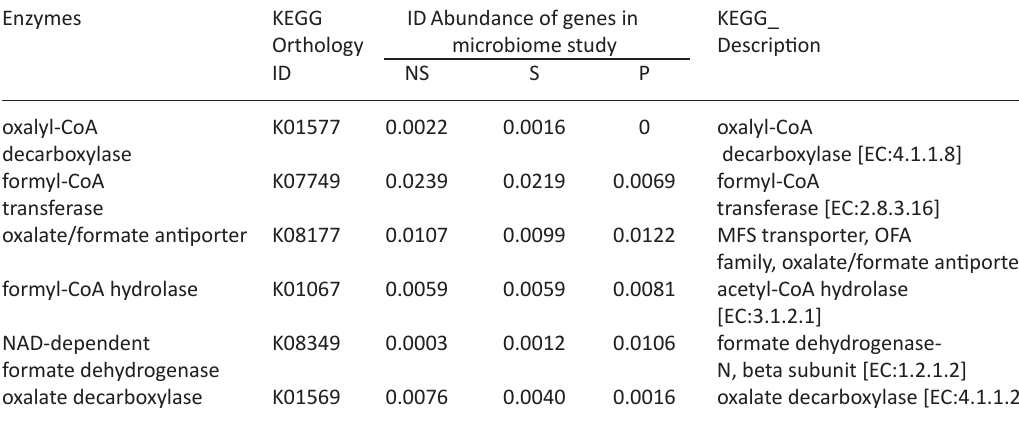
Table 2. Bacterial enzymes describing the oxalate metabolizing potentials in the microbiome derived from the imputed metagenomic approach. Selected oxalate metabolizing ability governing genes in microbiome as mentioned earlier by Suryavanshi et. al., 2016